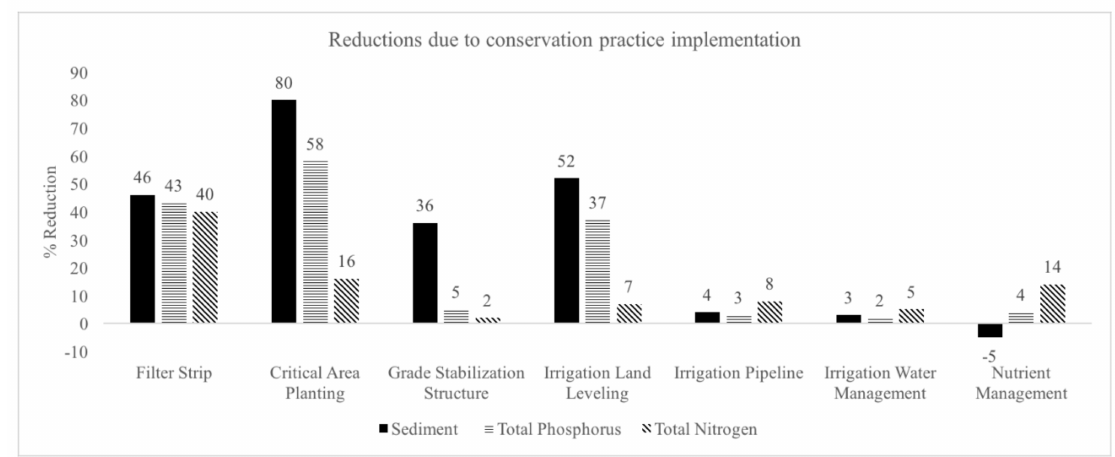
Figure 6. Percentage reductions in sediment and nutrient losses due to simulation of